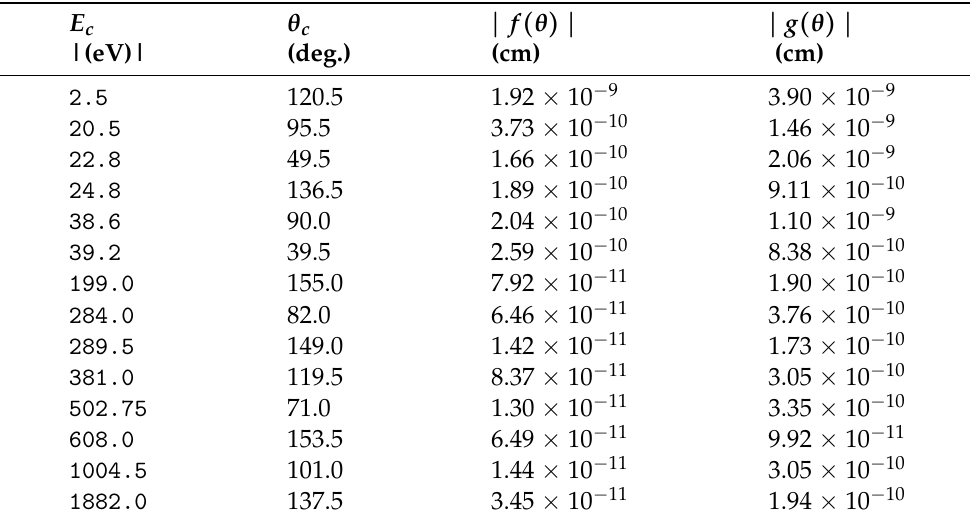
Table 1. The positions of the DCS CM predicted by the present theory for electrons elastically scattered from neutral radon